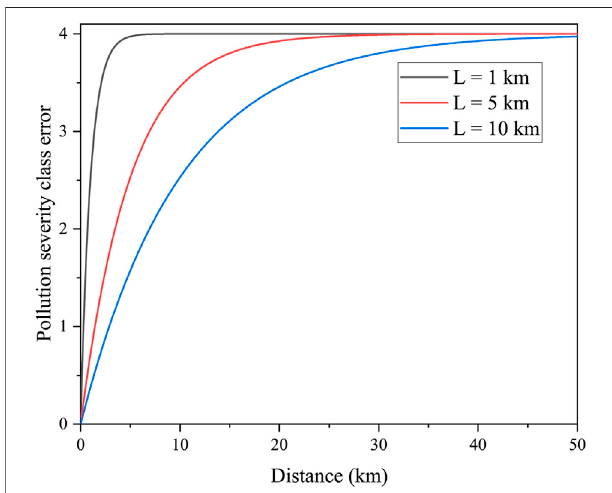
FIGURE 6 | Location of manual measurement points.